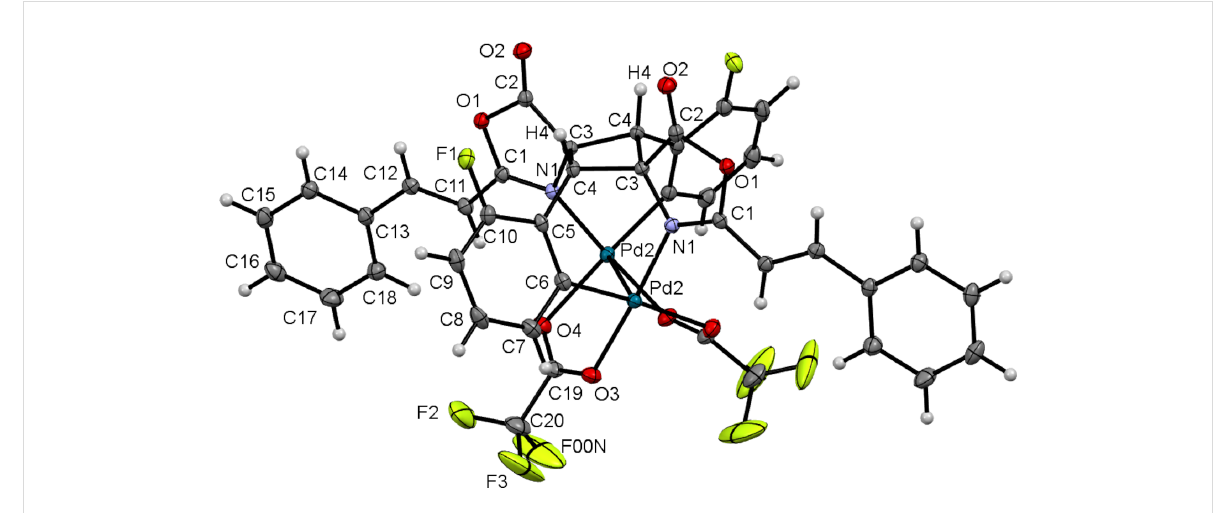
Figure 5: Molecular drawing of cyclobutane ortho -palladated 4a . Ellipsoids are shown at the 50% probability level.